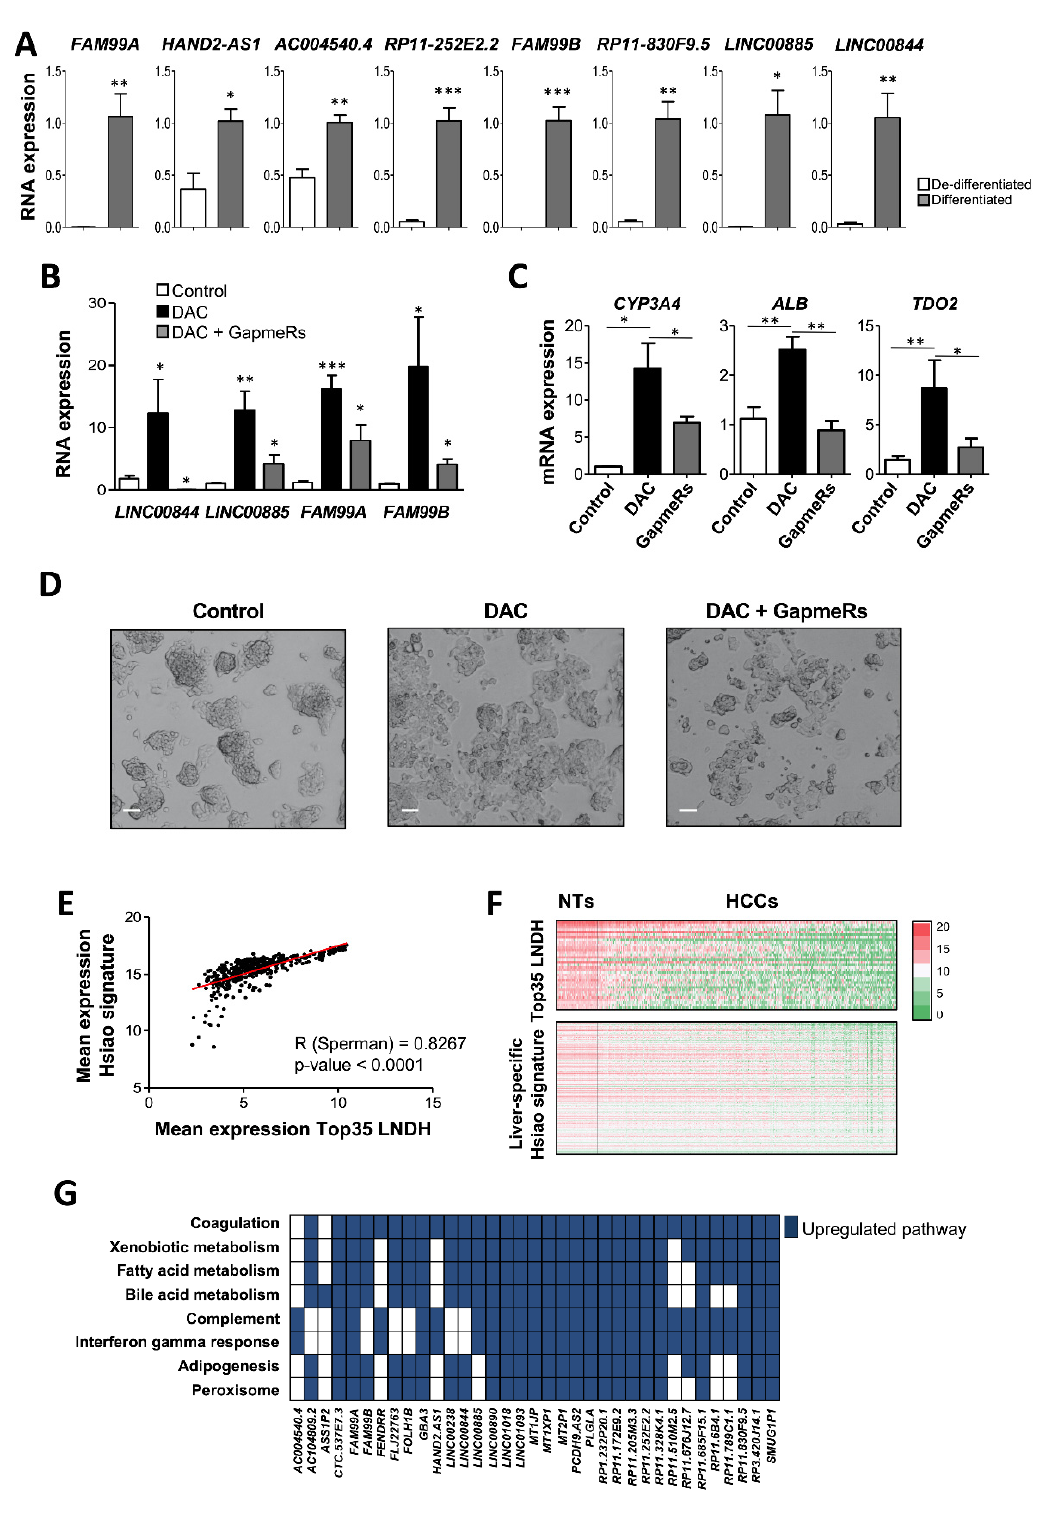
Figure 5. The Top35 LNDH participate in liver differentiation. ( A ) Expression levels by RT-qPCR of the 8 selected lncRNAs in de-differentiated human hepatoma cell line HepaRG compared to hepatocyte-like well-differentiated HepaRG cells. Experiments were performed at least three times in duplicate. ( B , C ) Histograms reporting LINC00844 , LINC00885 , FAM99A , FAM99B ( B ), CYP3A4 , ALB and TDO2. ( C ) mRNA level by RT-qPCR in HepG2 cells after three days cultured with and without 10 µM of 5-Aza-2 ′ -deoxycytidine (DAC), or after treatment with 10 µM DAC simultaneously to the transfection with a combination of specific GapmeRs for LINC00844, LINC00885, FAM99A and FAM99B . RPLP0 expression was used as a housekeeping gene. All experiments were performed at least three times in duplicate. ( D ) Representative images of HepG2 cells three days after culture